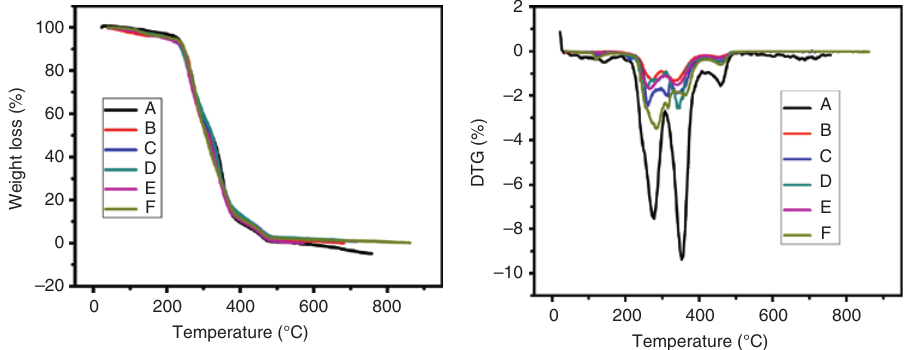
O nanoparticle (C) blend + 1 wt% Fe 2 3 O nanoparticle (F) blend + 2.5 wt% Fe 2 3